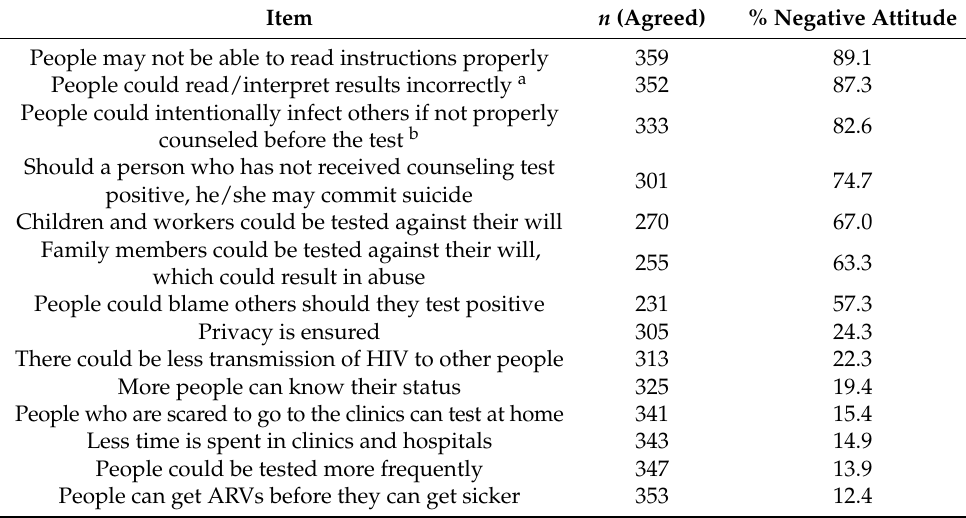
Table 3. HIV self-testing (HIVST) negative attitude ( n = 403).